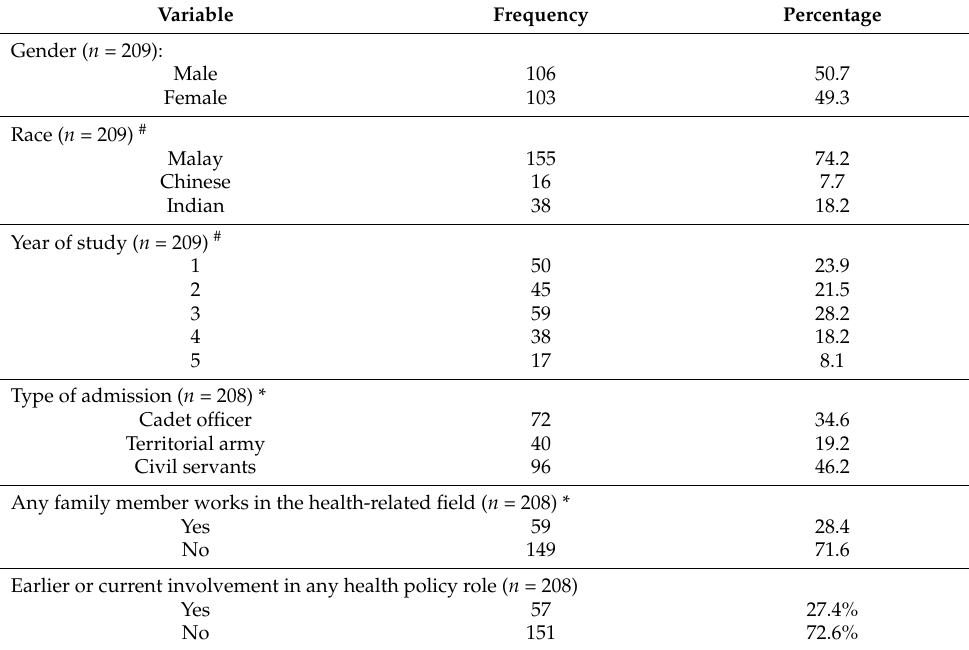
Table 1. Sociodemographic information of the medical students ( n = 209).